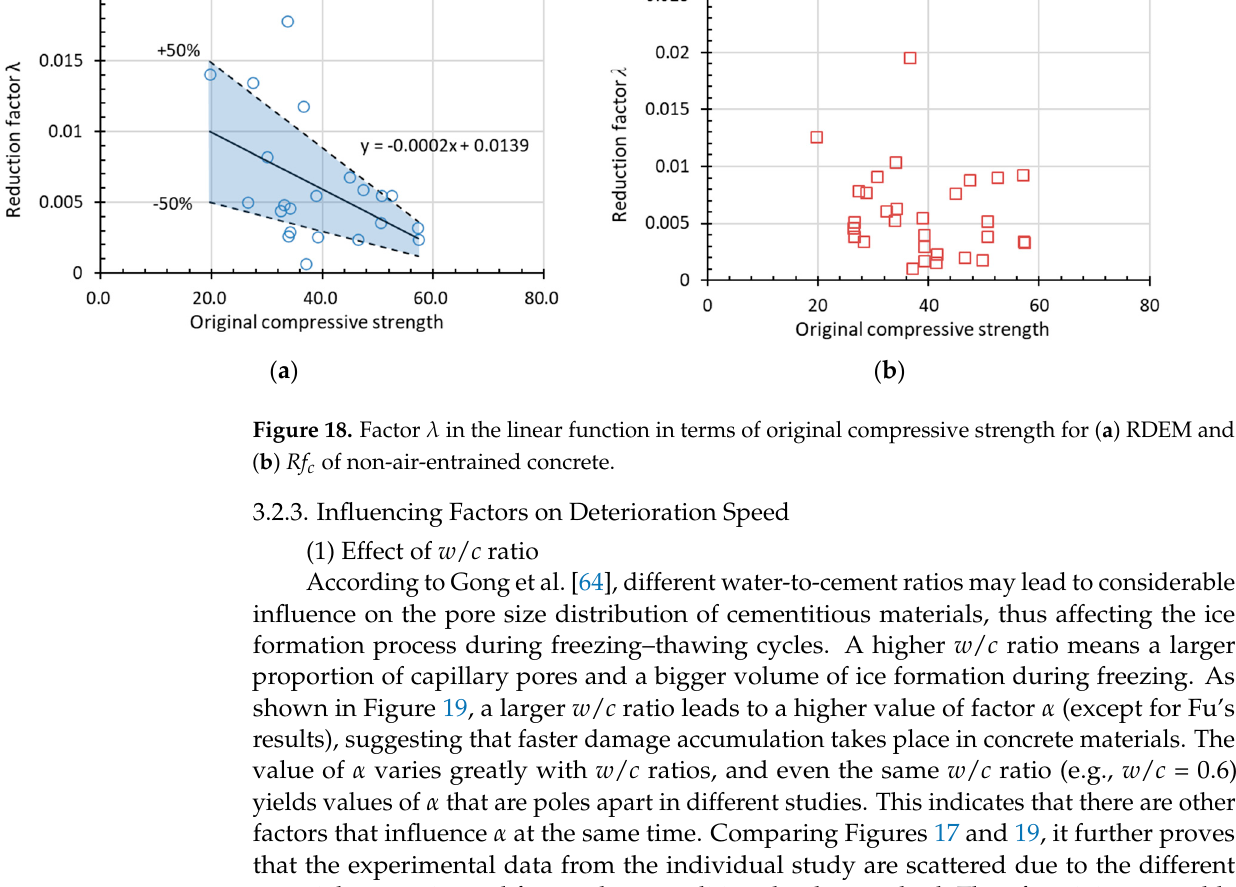
Figure 17. Factor λ in the linear function in terms of w/c for ( a ) RDEM and ( b ) Rf c of non-air-entrained concrete.